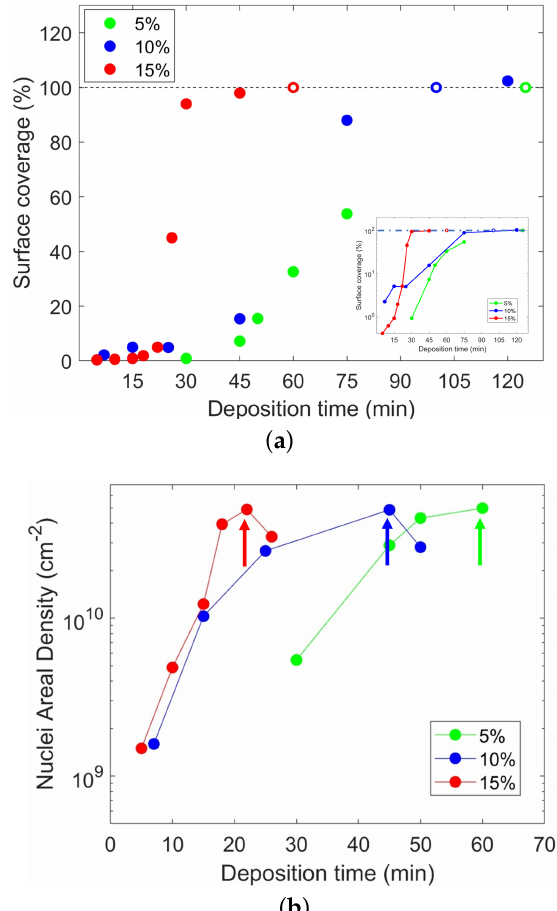
Figure 2. ( a ) Surface coverage as a function of deposition time. The dashed line indicates 100% coverage. Coverage higher than 100% refers to full monolayer coverage plus additional coverage deriving from forming a second layer on top of the first. ( b ) Nuclei areal density of the samples vs. deposition time. The arrows indicate the nuclei density maximum value, after which there is a decrease due to the coalescence